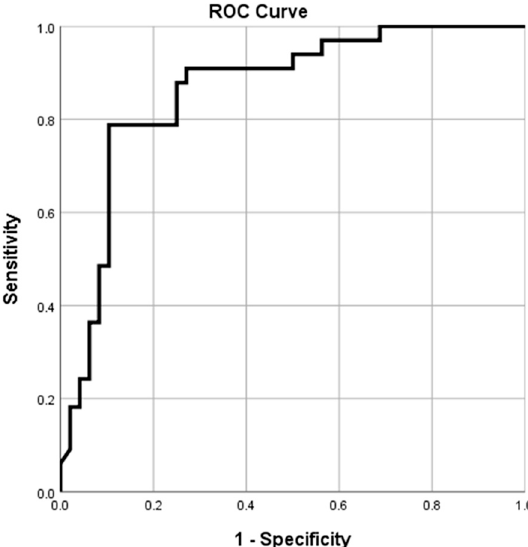
Figure 5. The receiver operating characteristic (ROC) plot of handgrip strength (HGS) and peak inspiratory flow rate (PIFR) for Turbuhaler. The best cutoff value of HGS for Turbuhaler is 31.9 kg, with the area under the ROC curve of 0.862 (95% CI; 0.779–0.945, p < 0.001), 79% sensitivity, and 90% specificity.